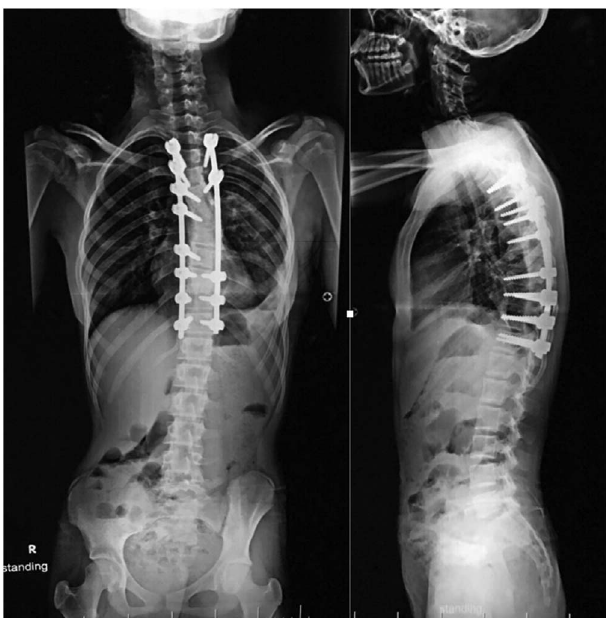
Figure 5. Postoperative full-length PA and lateral whole spine radiograph showing the correction of the scoliotic curve to 30 (cid:1) and the thoracic kyphosis to 32 (cid:1)